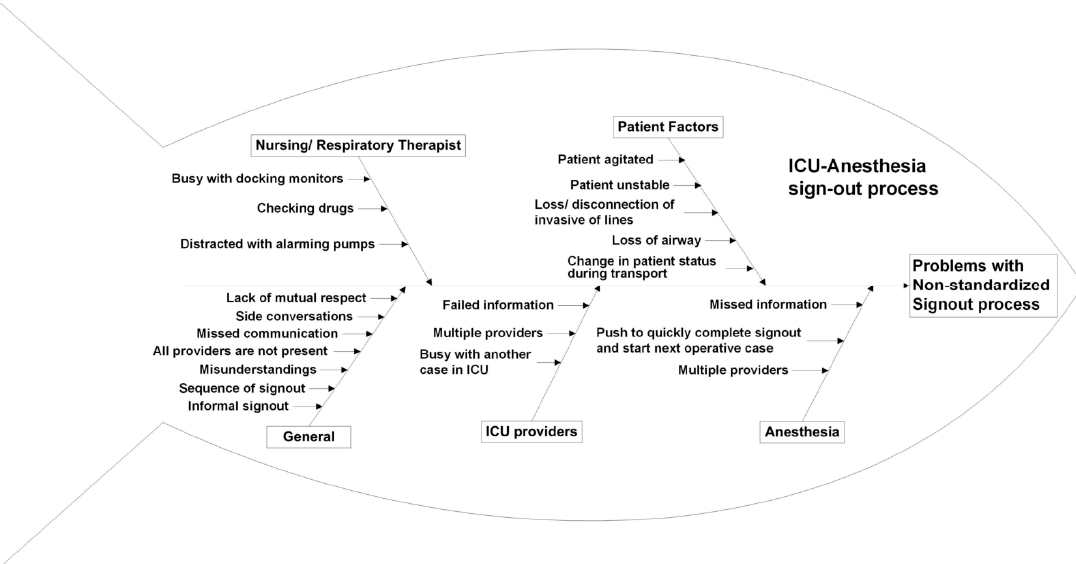
Figure 1. Fish bone diagram showing the causes of the problems contributing to an inefficient/ineffective hand-off process between the anesthesia and operating room teams.